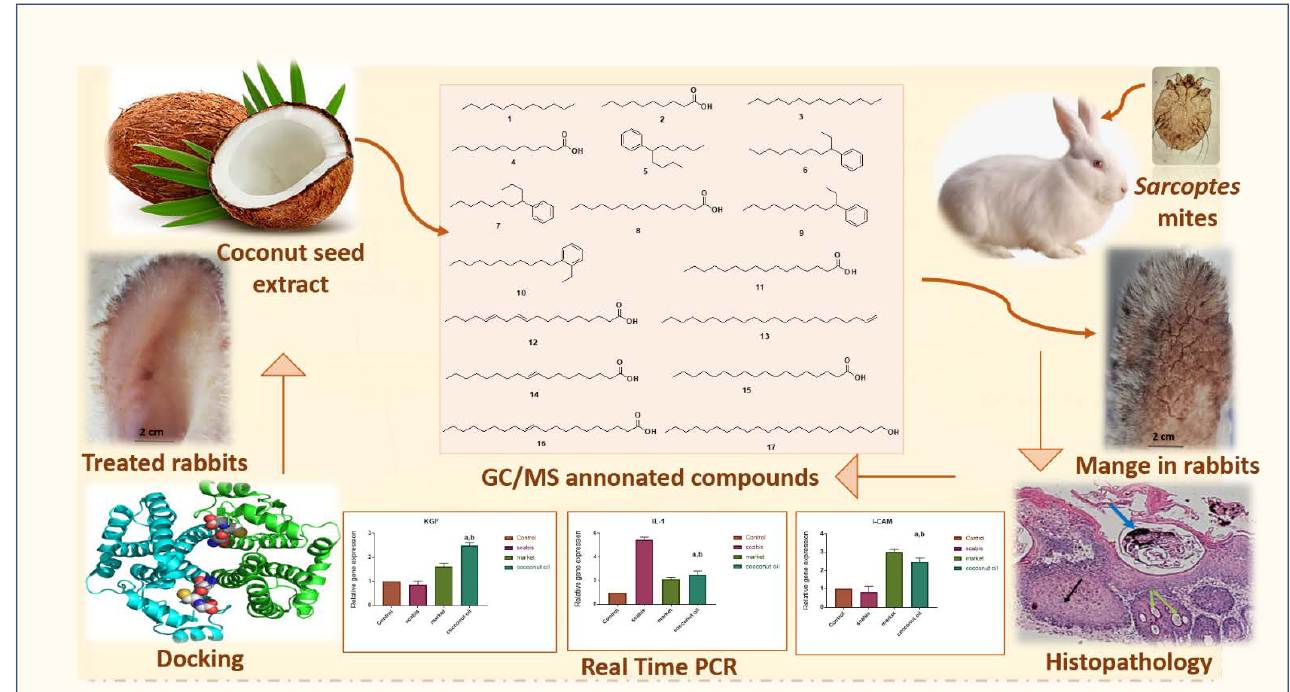
Figure 1. The general summary of the present research is as follows: the phytochemical composition as well as GC-MS profiling of coconut seed extract (CSE) was employed. Additionally, the scabicidal potential of CSE on sarcoptic mange in rabbits was investigated via in vitro, in vivo, histopathology, mRNA expression, and docking analysis.